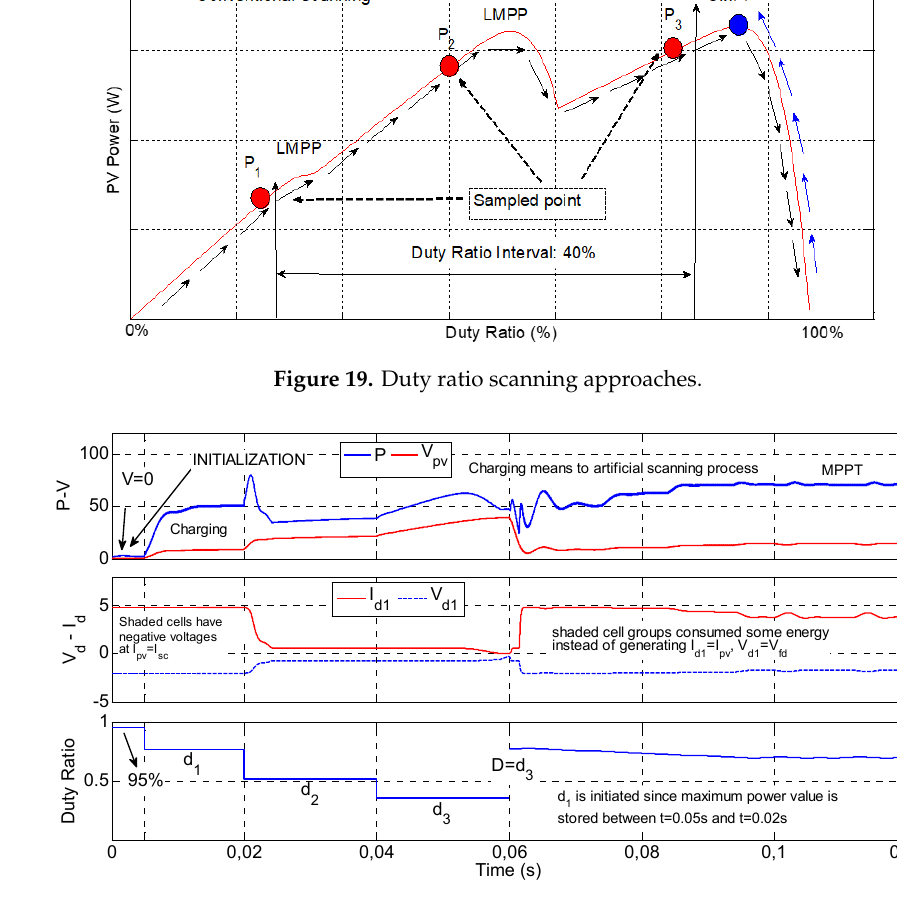
Figure 20. Summary of the proposed algorithm shown in a PSC operations.